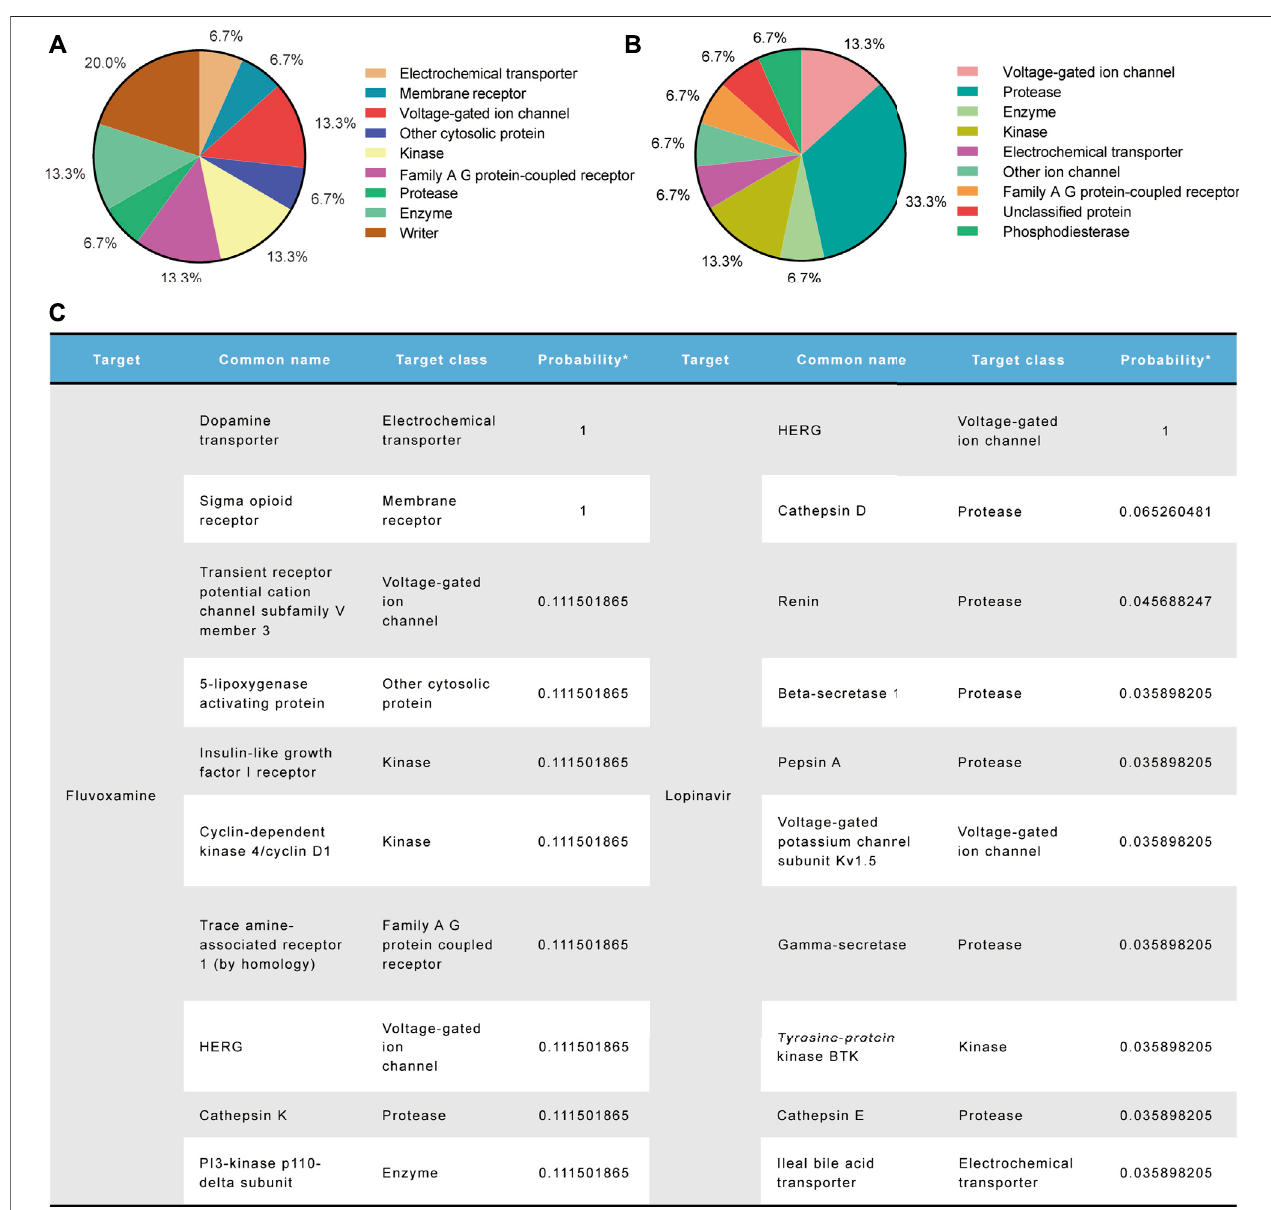
FIGURE 7 | Molecular target prediction for FLV and LPV. (A,B) Pie charts summarize the predicted target classes for the top 15%. (C) Top 10 ranked target molecules for both compounds according to the probability values.